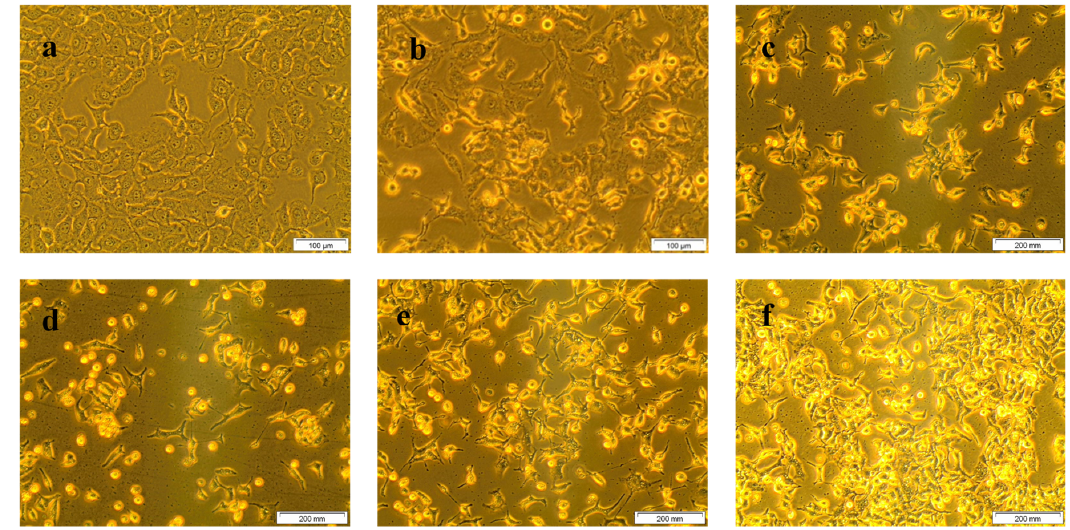
Figure 2. Morphological changes of A549 cells due to the result of CA treatment in different doses (40× magnification). Where, ( a ) are untreated cells; ( b ), ( c ), ( d ), ( e ) and ( f ) are cells were treated with 20, 40, 60, 80, and 100 µM of CA, respectively. Morphological changes, including rounding of cells, detachment, floating cells in culture media, and brightly illuminated dead cells were observed in the images. It was clear that a steady increase in the aforesaid morphological changes identifying cancer cell death were noted in CA treated cells ( b – f ) with reference to untreated control cells revealing the dose-dependent cell growth inhibition of CA.